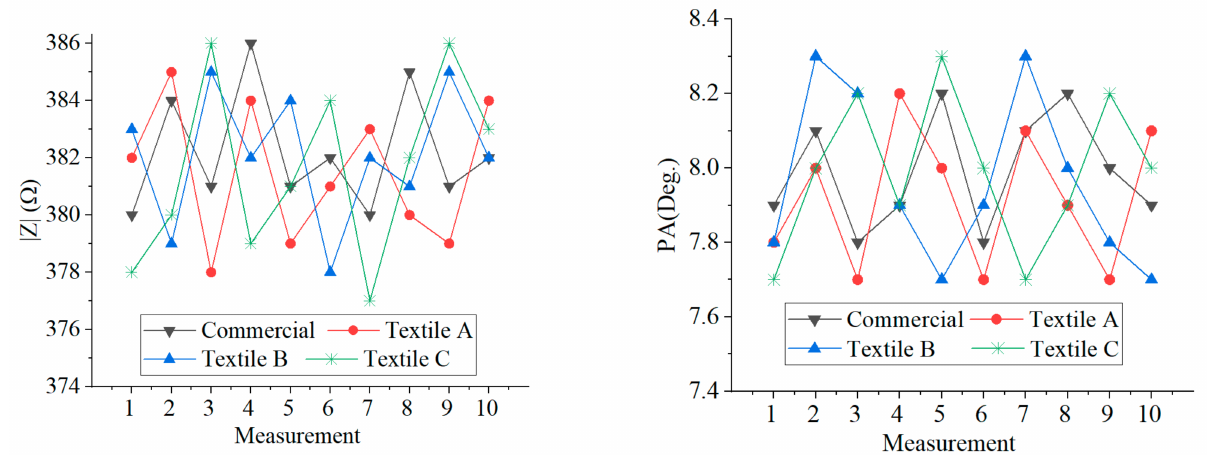
Figure 7. Results of the ten measurements performed on PUT